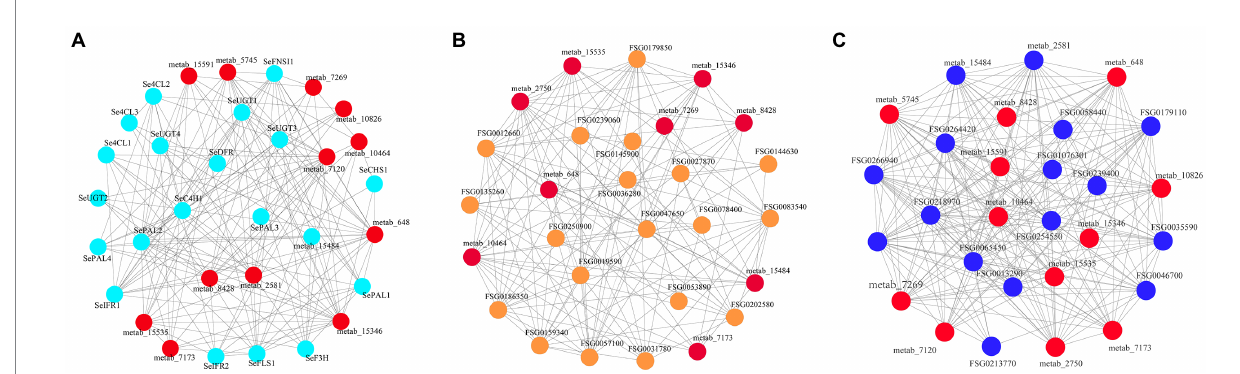
FIGURE 9 Connection network between DEGs and TFs associated with flavonoid synthesis and DEMs in chayote fruits during storage. (A) Correlation analysis between structural genes of flavonoid synthesis and flavonoids; (B) Correlation analysis between MYB TFs and flavonoids; (C) Correlation analysis between bHLH TFs and flavonoids. The red ellipsoid represents the DEMs. The light blue, yellow, blue, pink and green ellipsoid represent structure genes, MYB, and bHLH TFs, respectively.